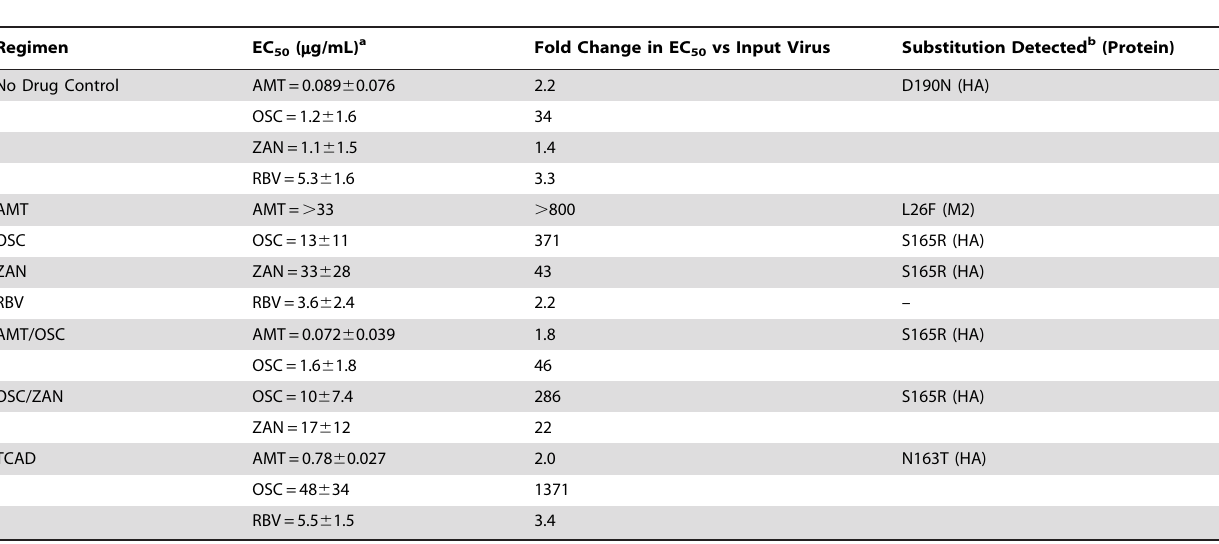
Table 3. Summary of Phenotype and Genotype of Supernatants after Serial Passage under Escalating Drug Concentrations.